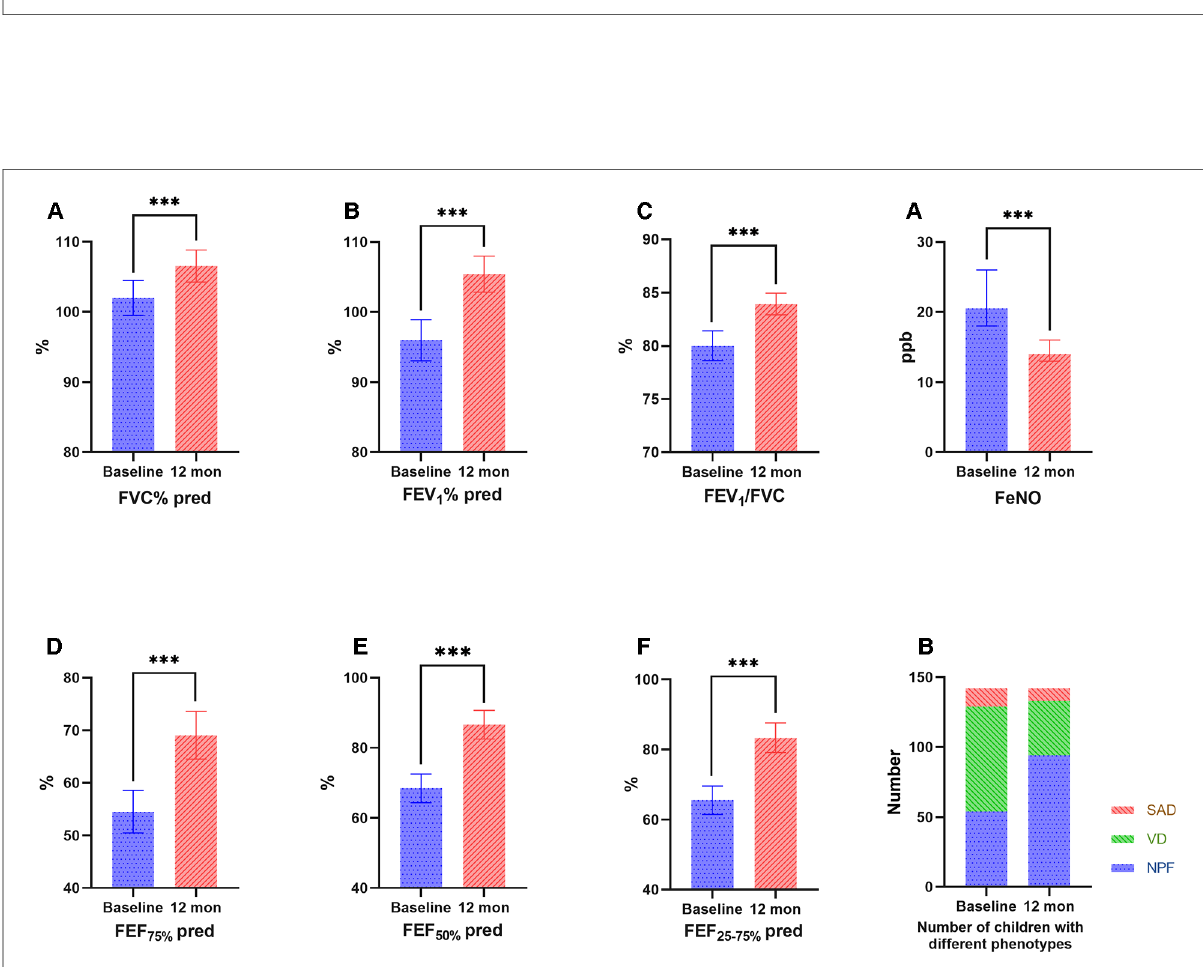
FIGURE 4 Comparison of large ( A : FVC%, B : FEV 1 , C : FEV 1 /FVC) and small ( D : FEF 75% , E: FEF 50% , F: FEF 25 – 75% ) airway function parameters, FeNO ( A ) and the number of children with different phenotypes ( B ) before and after treatment. FVC, forced vital capacity; FEV 1 , forced expiratory volume